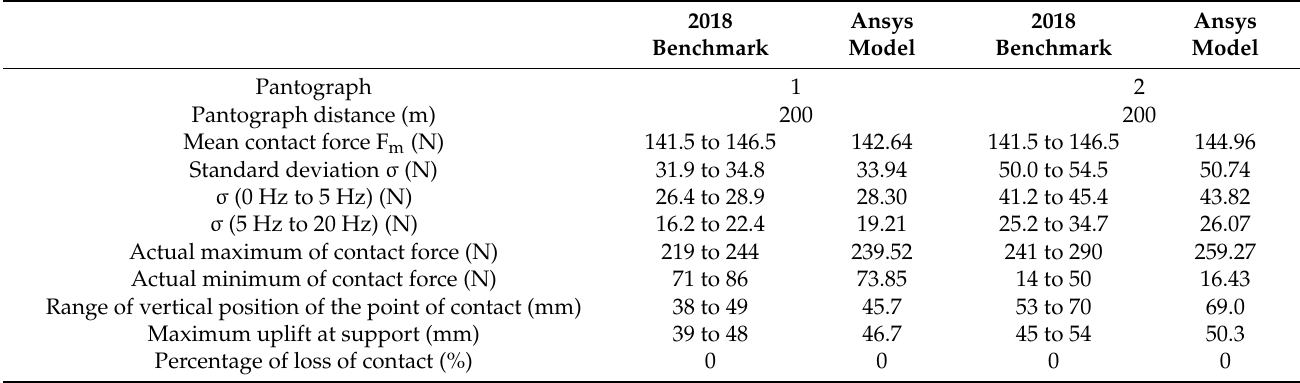
Table 4. Comparison of results from Ansys model against EN 50318:2018 ‘benchmark’, ‘AC simple’ 275 km/h, showing acceptable